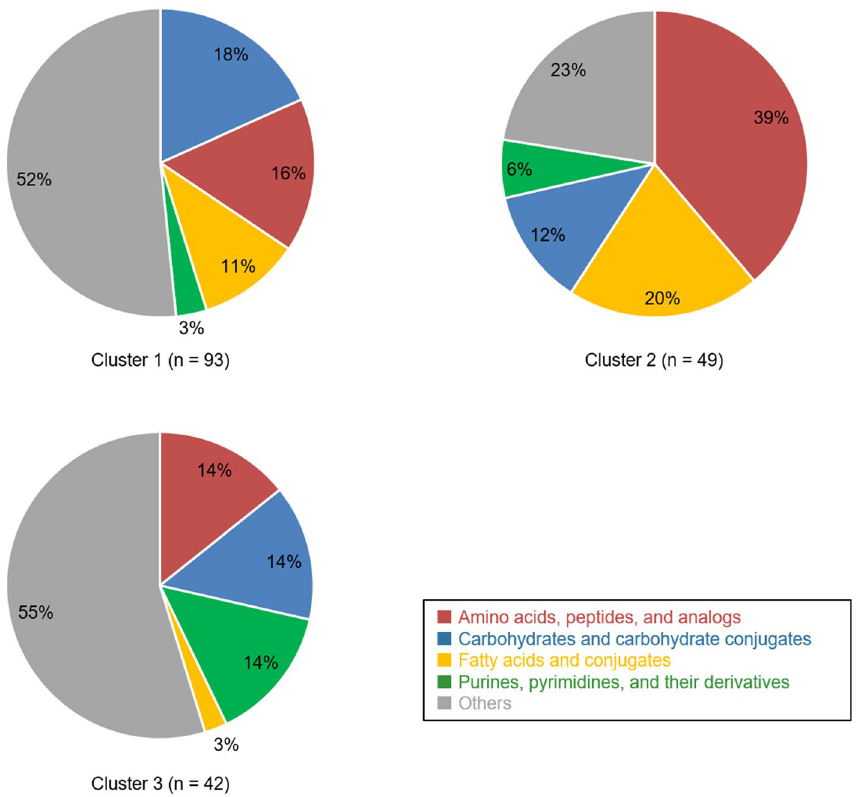
Figure 2. Proportions of metabolite types in each cluster. Red, blue, yellow, green, and gray sectors indicate “amino acids, peptides, and analogs,” “carbohydrates and carbohydrate conjugates,” “fatty acids and conjugates,” “purines, pyrimidines, and their derivatives,” and “others,”